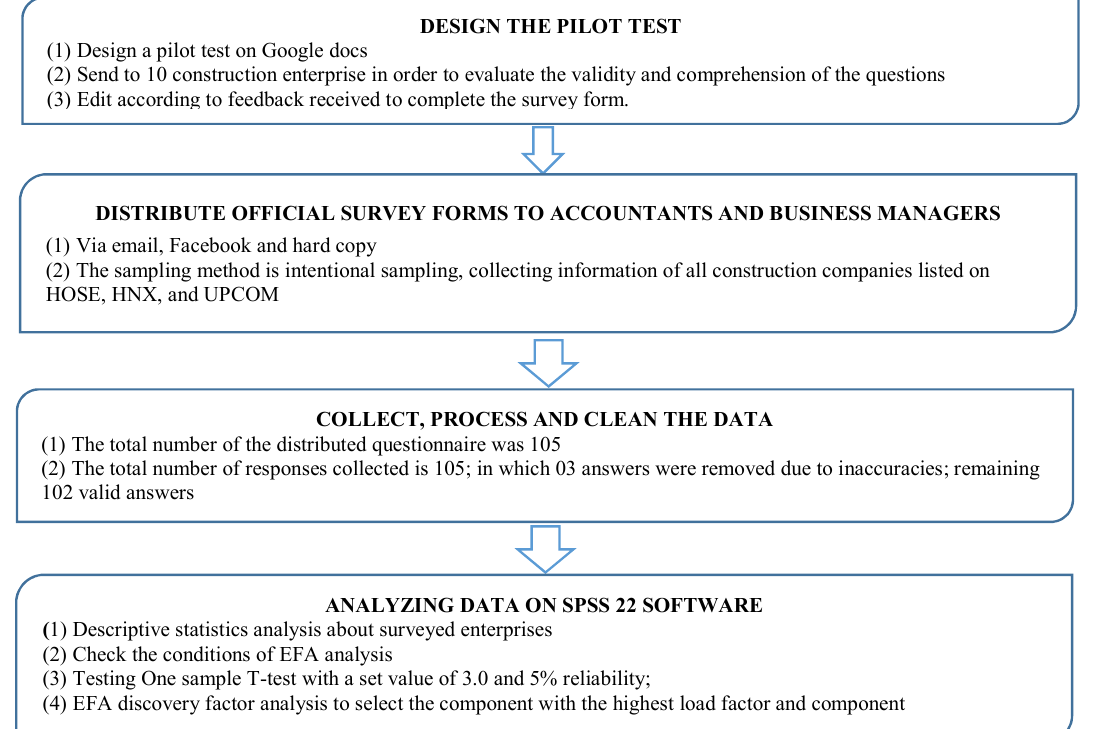
Source: authors’ results